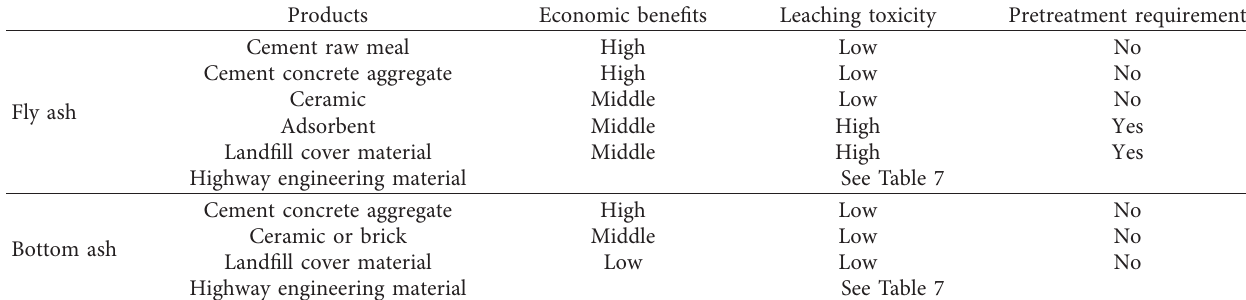
Table 5: Utilization of MSWI fly ash and bottom